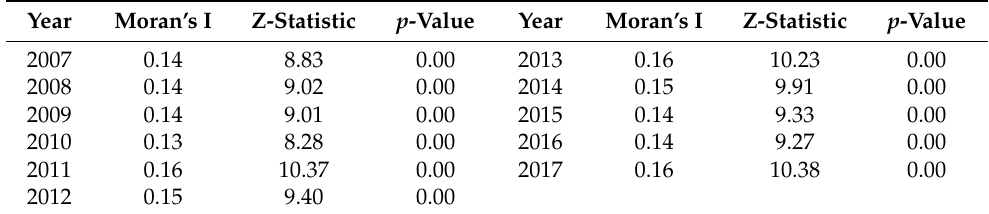
Table 2. Global Moran’s I of CEI in the YRB from 2007 to 2017.